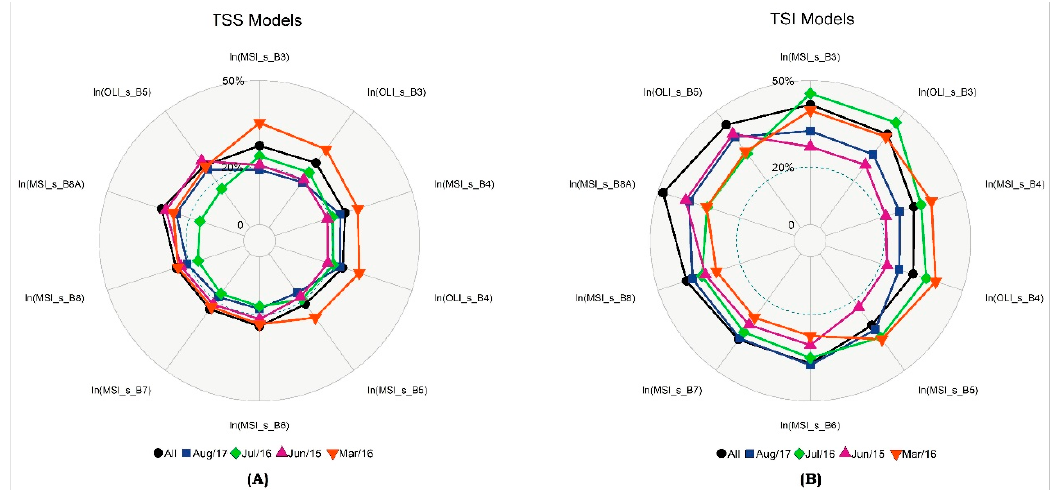
Figure 5. The Mean Absolute Percentage Error (MAPE) values (%) obtained through a Monte Carlo simulation for R rs,sim_sat for both sensors using log models based on the Campaign Dataset: ( A ) the log models for TSS and ( B ) the log models for TSI. The validation sample size for each campaign: June 2015 n = 9; March 2016 n = 5; July 2016 n = 8; August 2017 n = 5. The R 2 and RMSE are in the Supplementary Files A. “All” at the bottom in the legend for TSS and TSI refers to the MAPE values for the All Dataset models (The values are in Table 3).